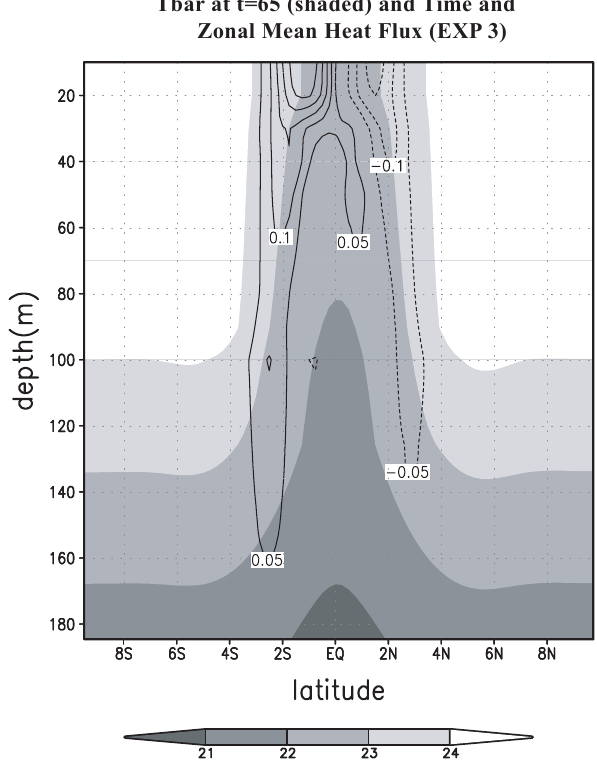
Fig. 4. Depth-latitude section of zonally averaged temperature (shaded, c.i.= 1 ◦ C) after 65 days of integration of EXP 3 and time and zonal mean v 0 T 0 (c.i.= 0.05cm ◦